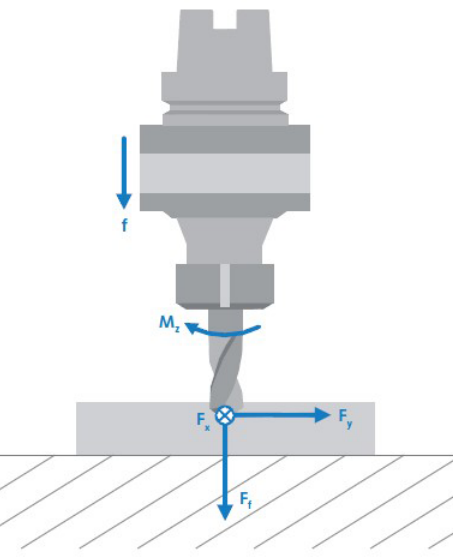
Figure 1. Cutting force for drilling